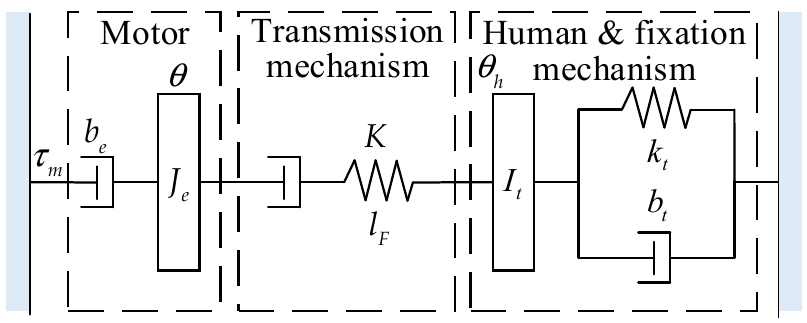
Figure 2. The fixation mechanism of the knee joint. τ m is the output torque of the current loop of the servo motor. J e and b e are equivalent moment of inertia and equivalent damping of the servo motor, respectively. is the angular displacement of the input shaft of the servo motor reducer. K and F